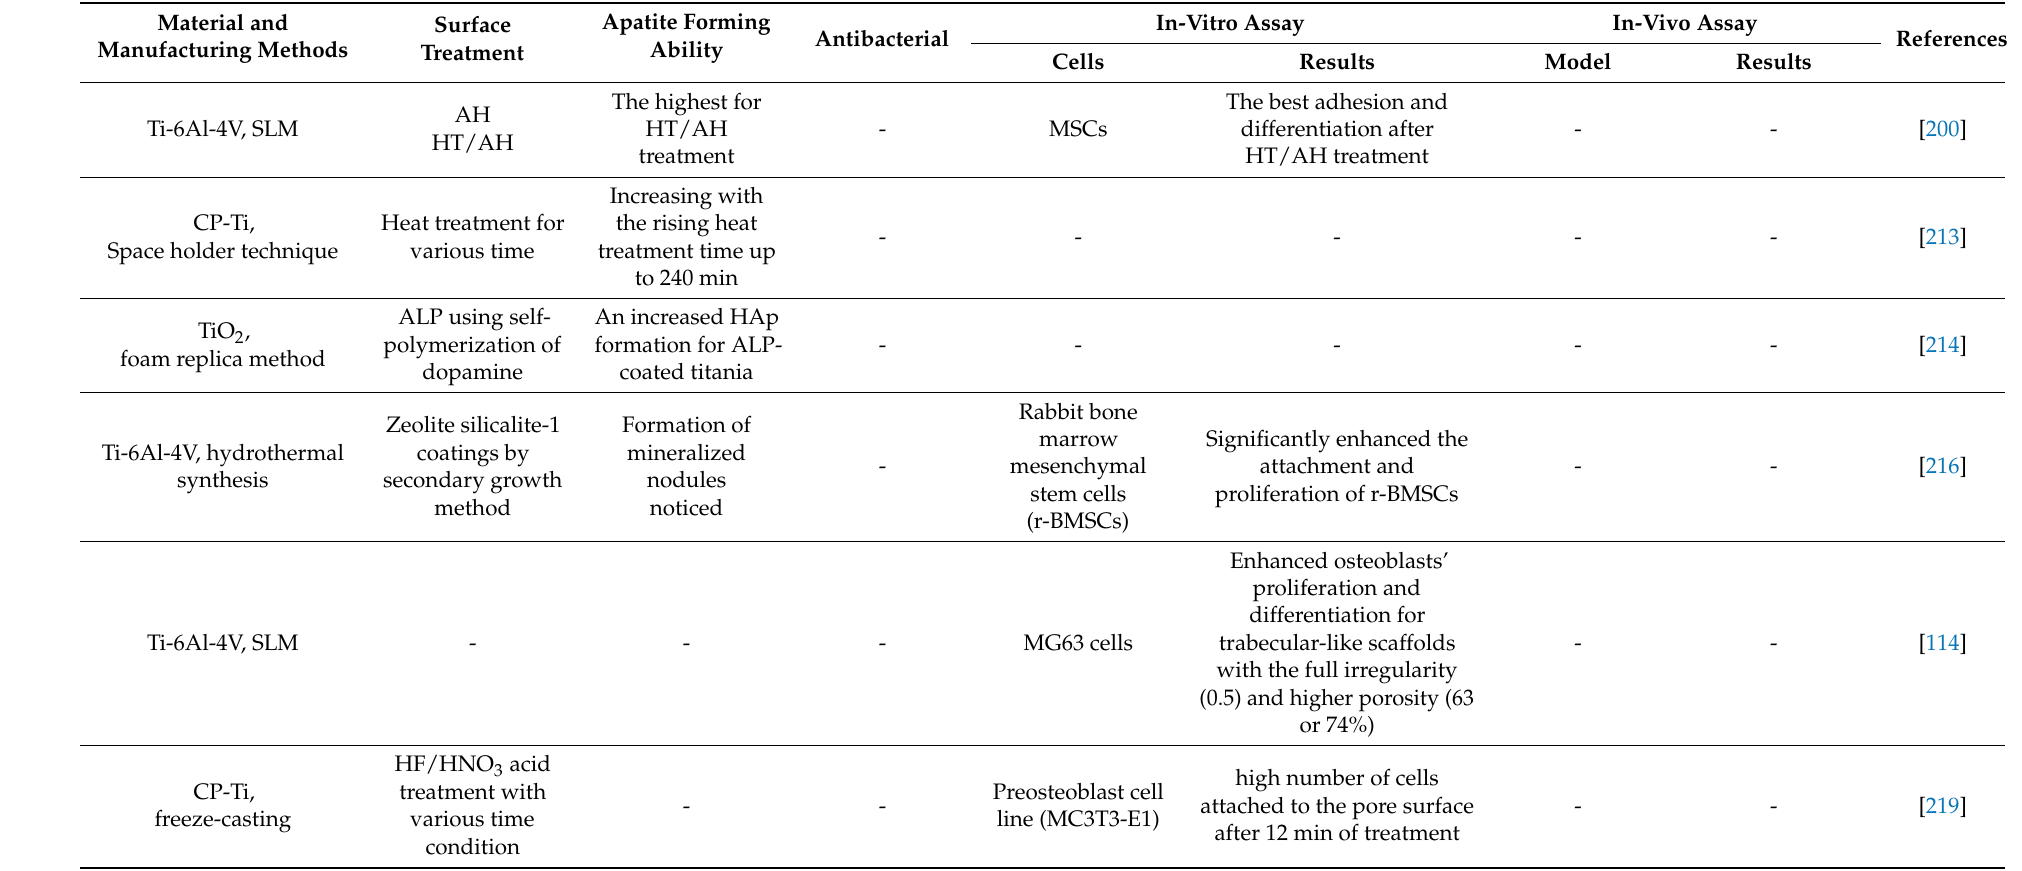
Table 7. The selected published data of biological properties of